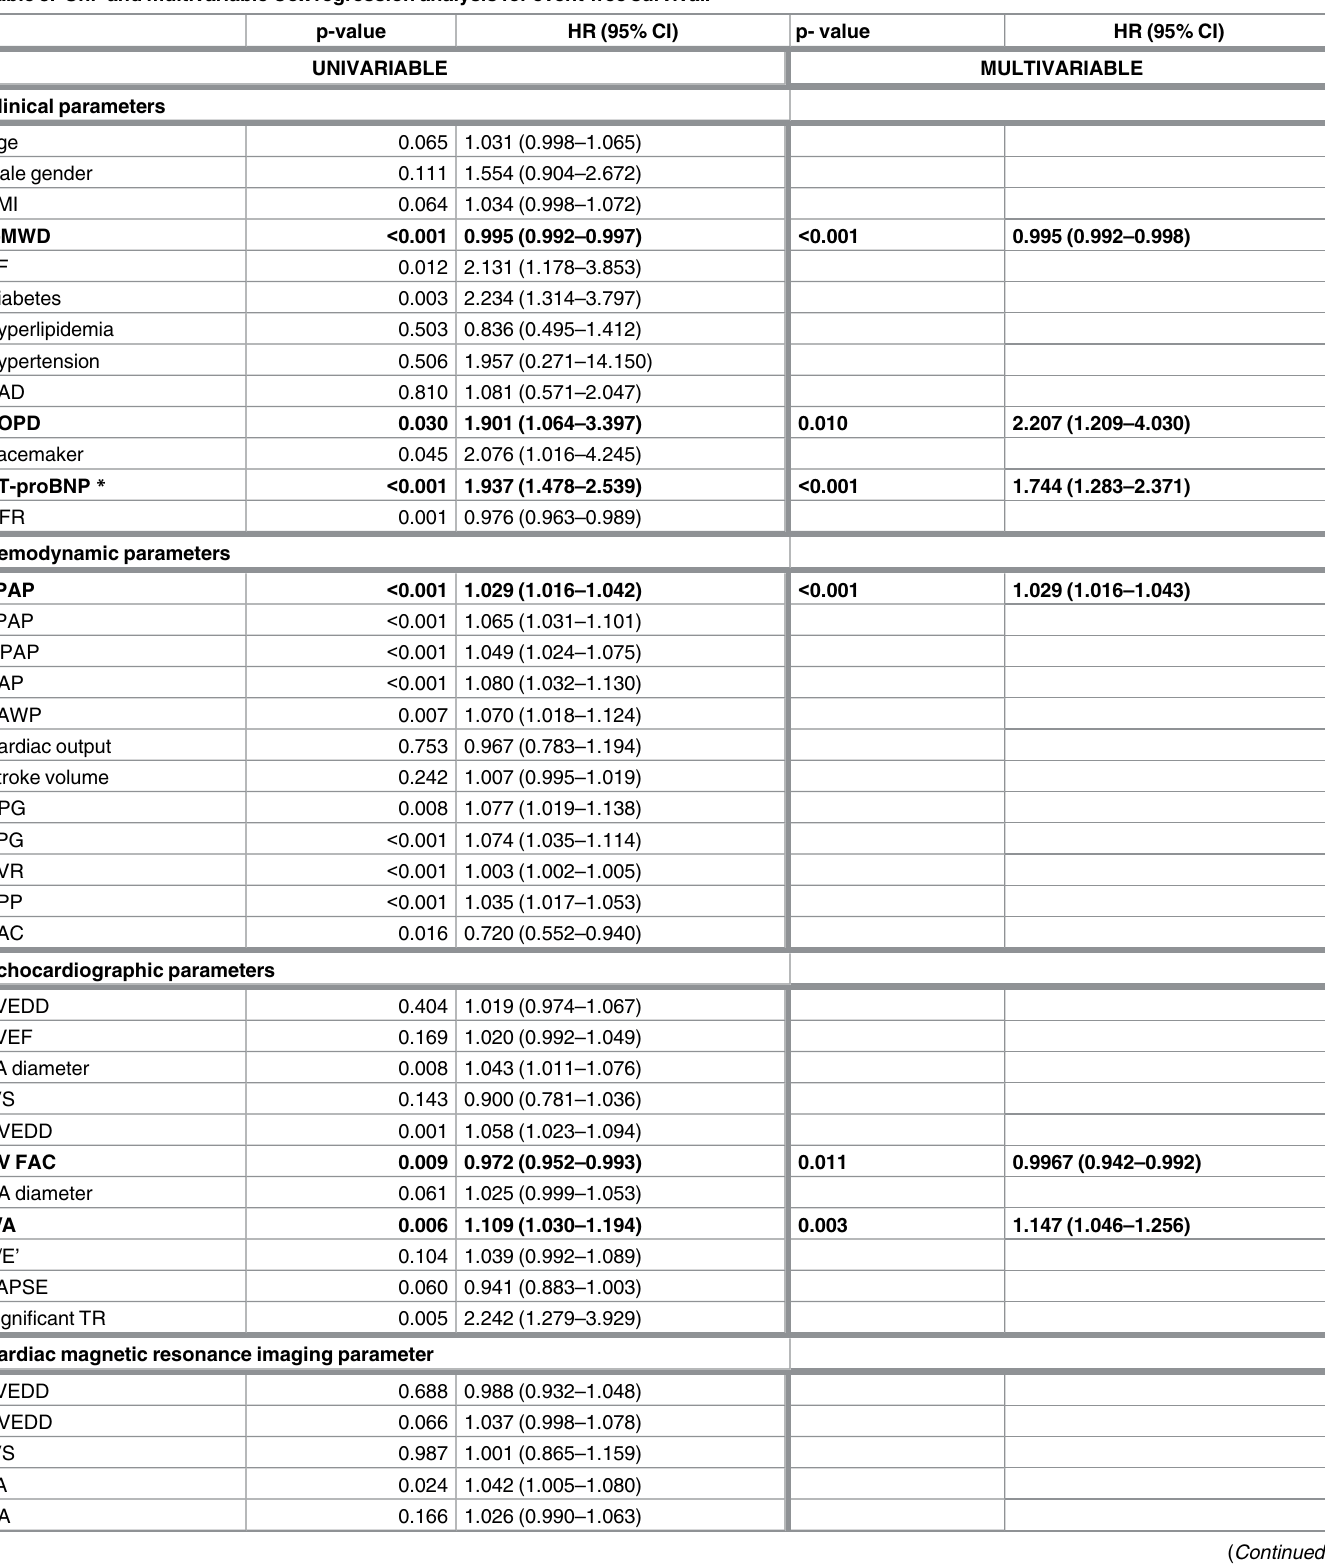
Table 8. Uni- and multivariable Cox regression analysis for